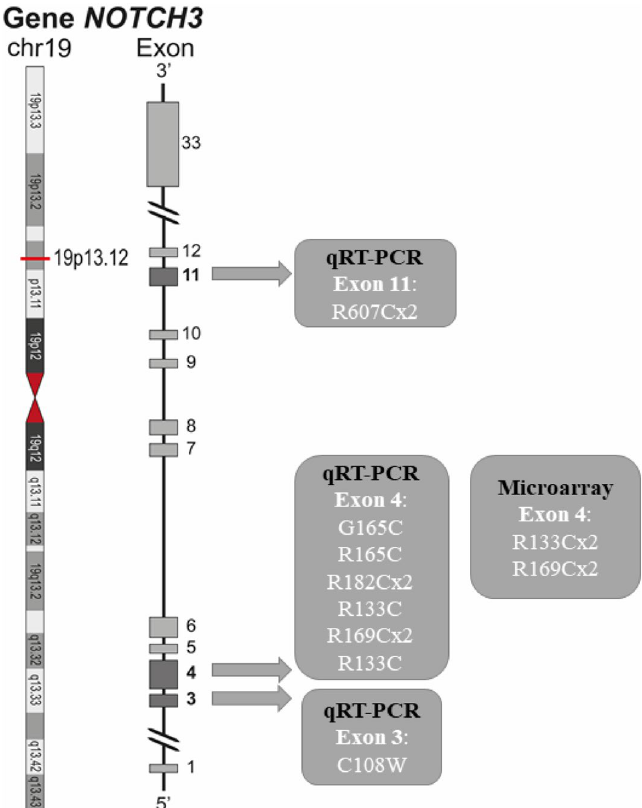
Figure 1. Distribution of mutations from the cases of the GWTS and qRT-PCR studies. Chr